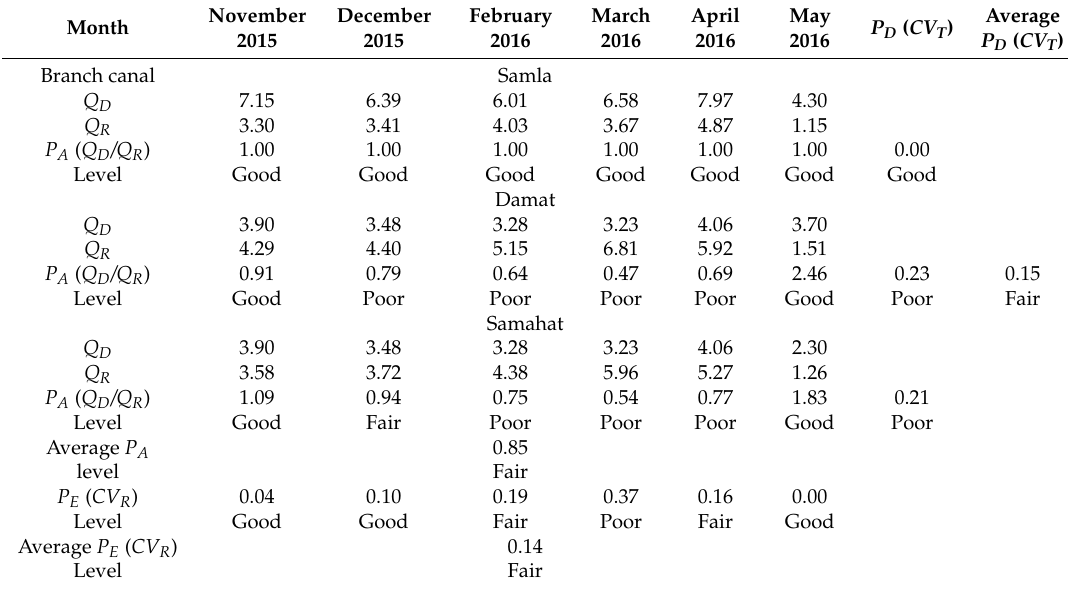
Table 8. The adequacy, equity, and dependability indicators for the Samla, Damat, and Samahat branch canals during the winter season (from November 2015 to May